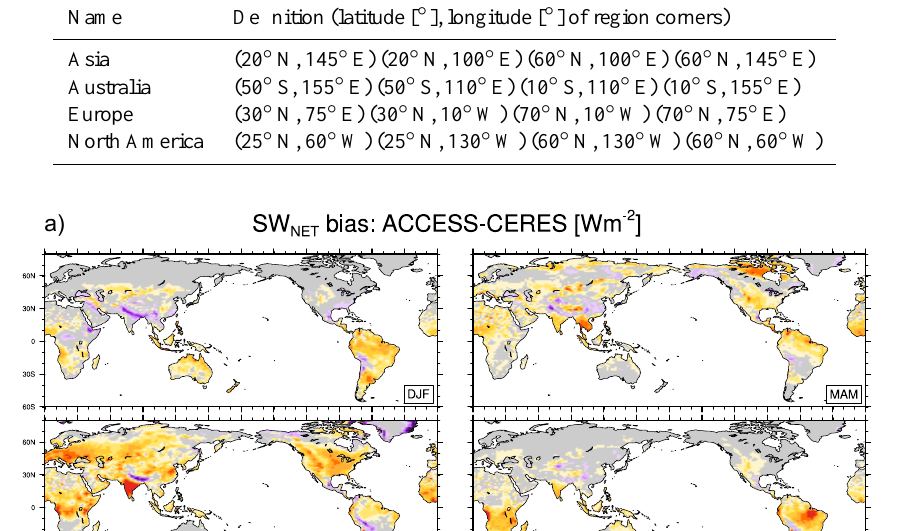
Table 3. Subregions used for probability density functions